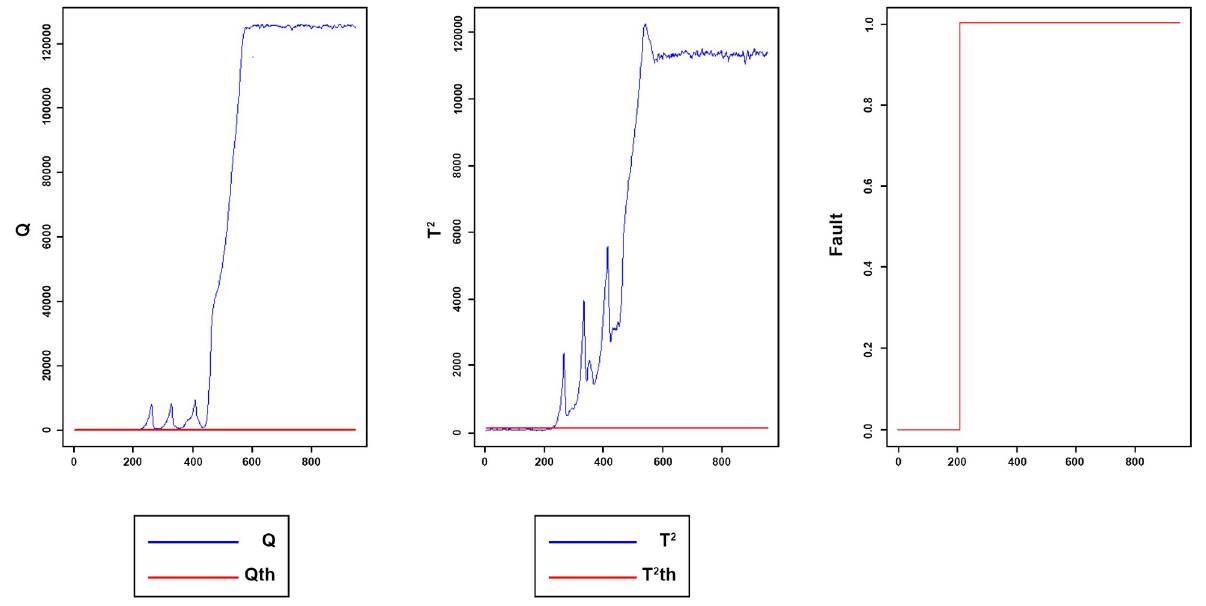
Fig 16. Monitoring performance of MWDPCA for fault